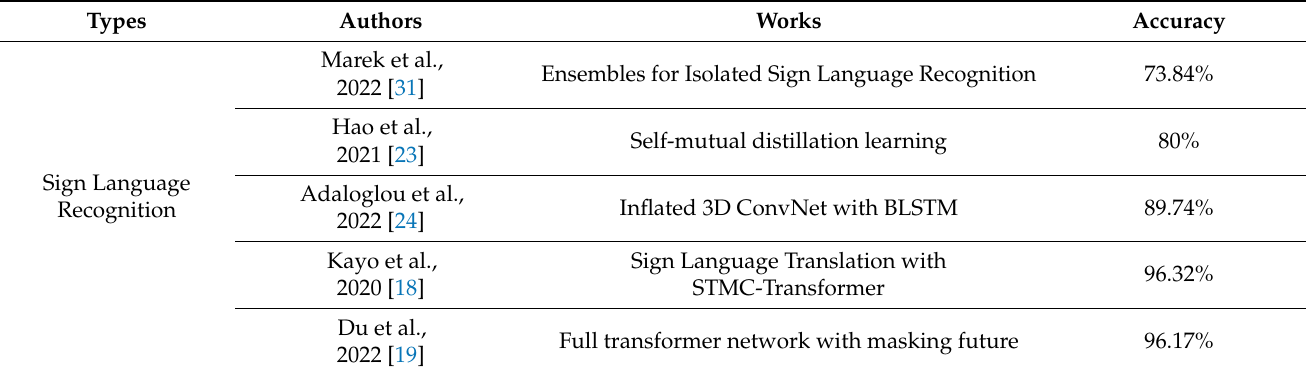
Table 10. Comparison of proposed work and previous